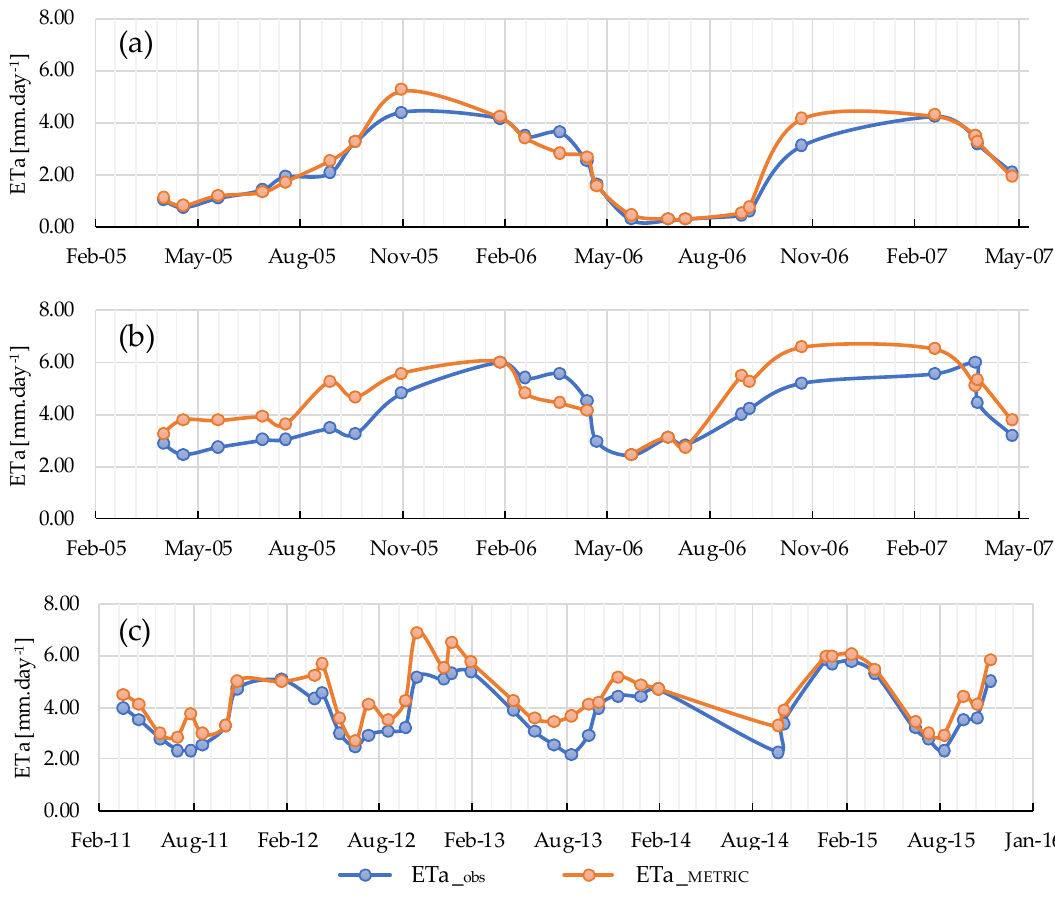
Figure 7. Temporal profiles of ETa (mm day −1 ) observed by the eddy covariance system (blue) and estimated by METRIC (orange), during the study period in each experimental site: ( a ) USR—sugarcane, ( b ) PDG—woody savanna, and ( c ) RECOR— sensu-stricto savanna.